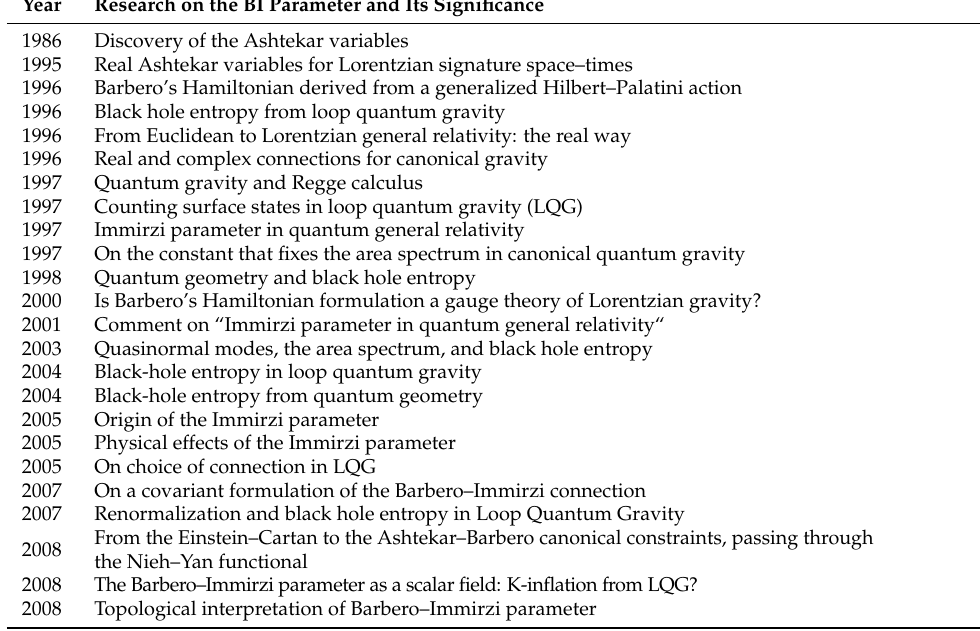
Table 1. Timeline of research on the Barbero–Immirzi